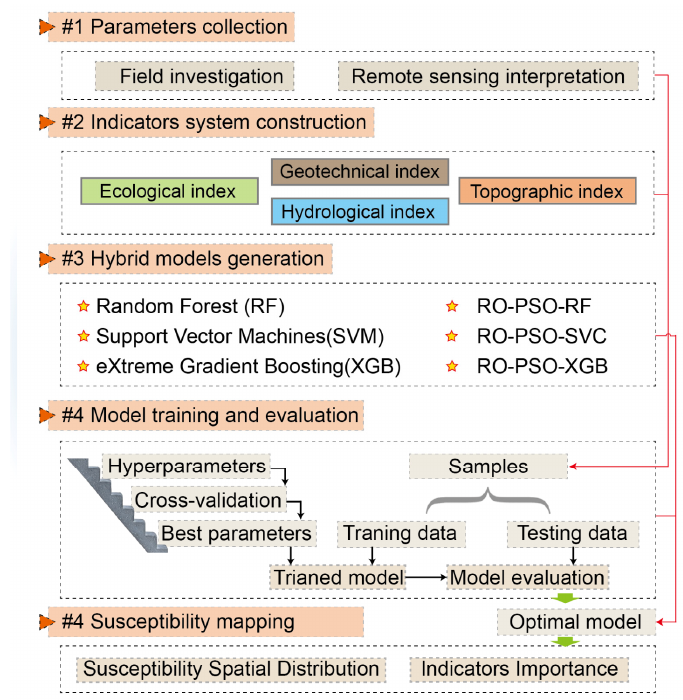
Figure 2. Methodological flow